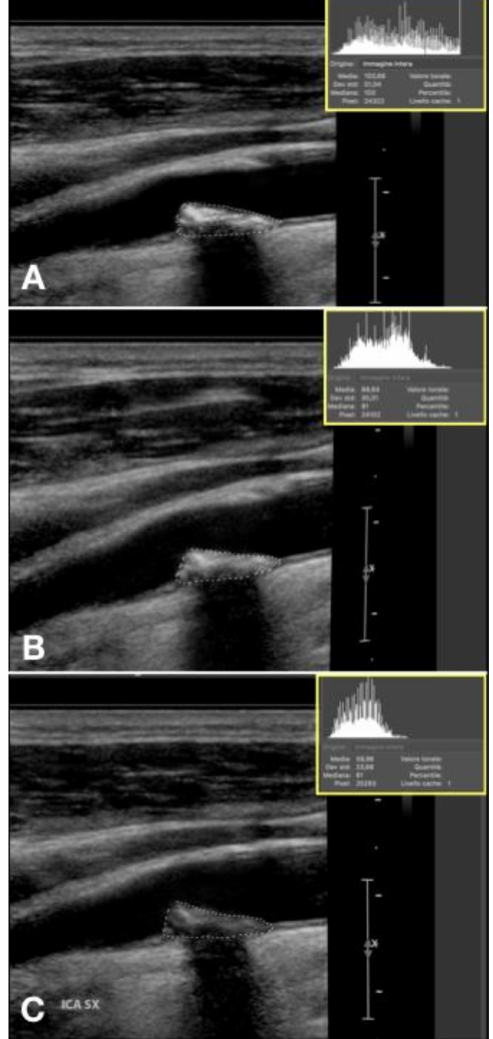
Figure 9. Plaque showing echogenicity decrease in 12 months treatment with vitamin K2. ( A ) start, GSM 103, ( B ) 6 months, GSM 91, ( C ) 12 months, GSM 61. The qualitative assessment of plaque composition showed that at baseline, hyperechoic plaques were found in 45% of the total population (27 patients): 13 in the ASA + K2 arm and 14 in the ASA arm ( p = 0.999). At 12 months, no difference was observed in plaque-type distribution compared to baseline ( p = 0.999), with hyperechoic plaques found in 48.3% of the total (29 patients): 14 in the ASA + K2 arm and 15 in the ASA arm ( p = 0.999). At multivariable analysis, the adjusted mean GSM change per month from baseline was greater in the ASA + K2 arm ( − 0.55 points (1.10, − 0.01), p = 0.048 versus baseline) compared to the ASA arm ( − 0.18 points ( − 0.75, 0.39), p = 0.529 versus baseline) (Table